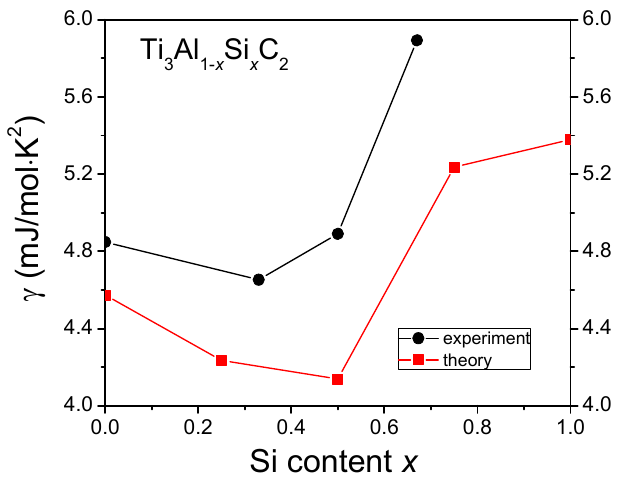
Figure 8. Dependence of the γ values on the Si content obtained from the experiment and calcula- tions.